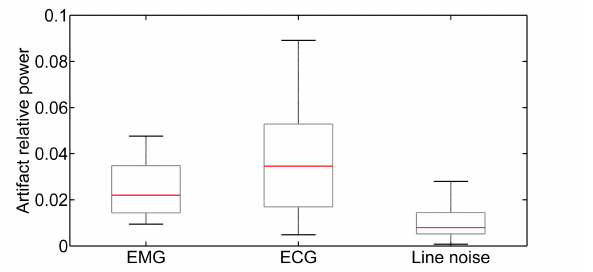
Figure 8. Box plot representing the relative power content of muscle (EMG), heart (ECG), and power line noise for all of the recorded